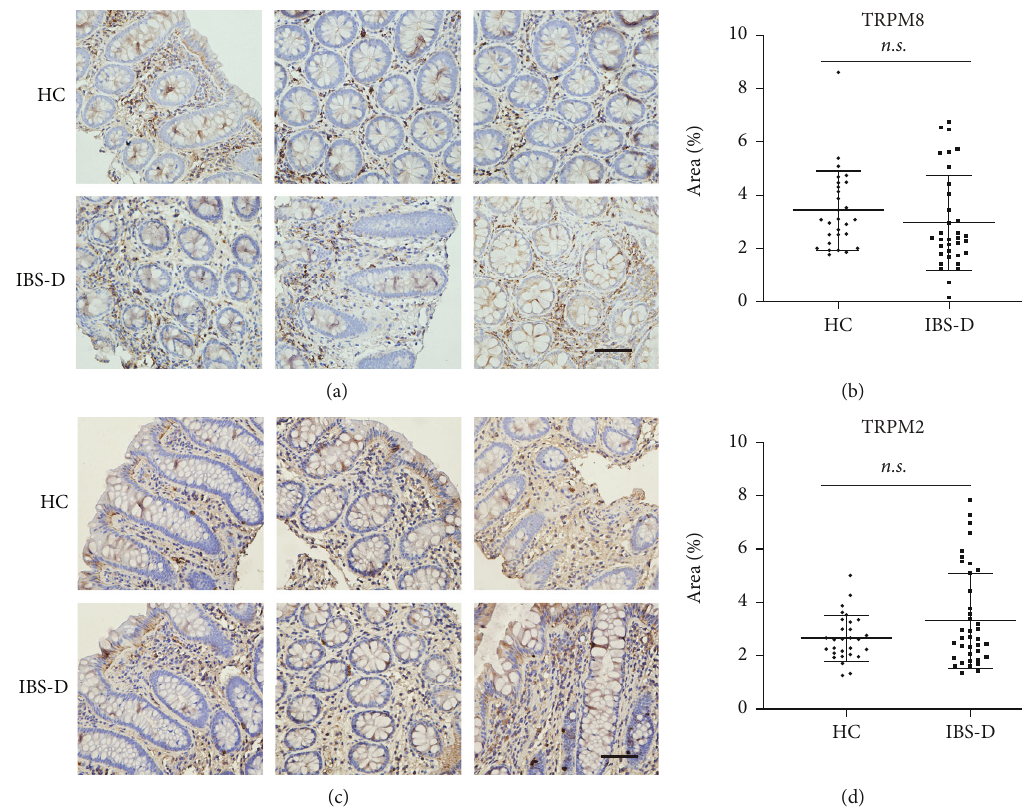
Figure 4: Expression of TRPM2 and TRPM8 did not di ff er between IBS-D patients and HCs. (a, b) No di ff erence in the expression of TRPM8 was found between IBS-D and HC groups. (c, d) No di ff erence in the expression of TRPM2 was found between IBS-D and HC groups. Scale bar, 50 μ